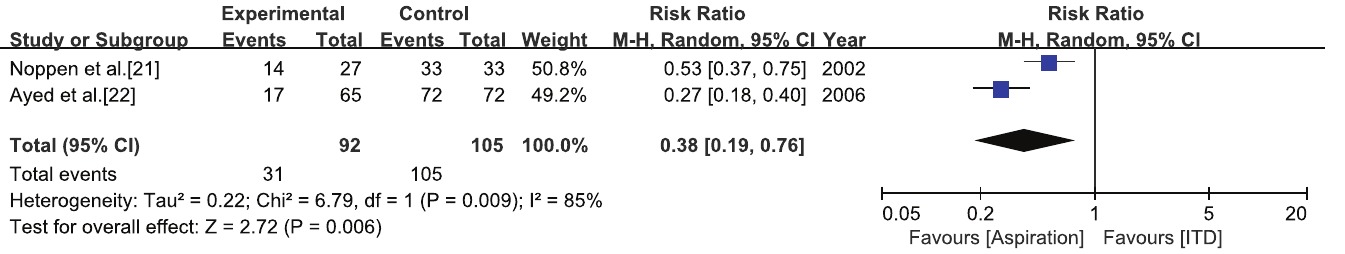
PLOS ONE | https://doi.org/10.1371/journal.pone.0178802 June 22,